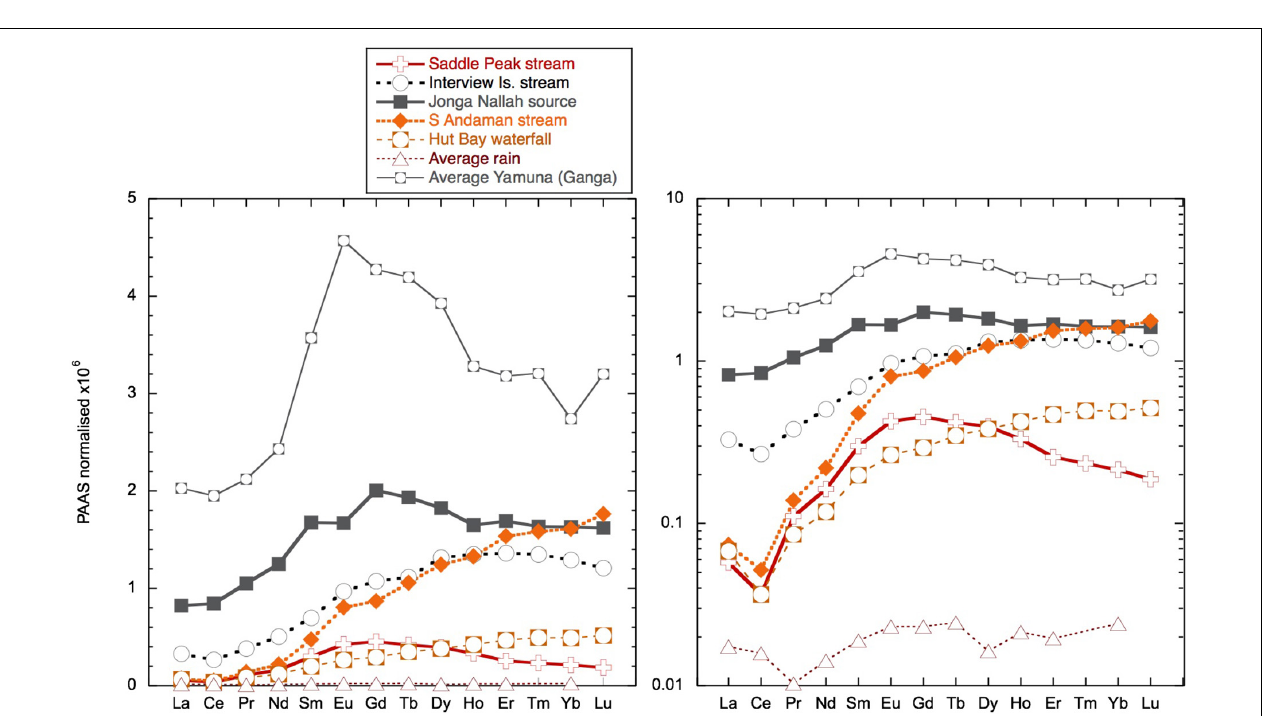
FIGURE 4 | Filtered seawater samples shale-normalized to Post-Archean Average Australian Sedimentary rocks (PAAS) (Nance and Taylor, 1976). Samples from the main locations use the same symbols: squares for Smith Island, vertical triangles for Avis Island, square rhombuses for Niel (Shaheed Dweep) Island, and horizontal triangles for Little Andaman Island.